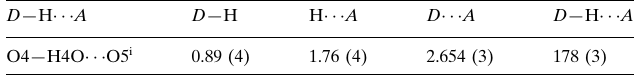
Hydrogen-bond geometry (A˚ , (cid:1)